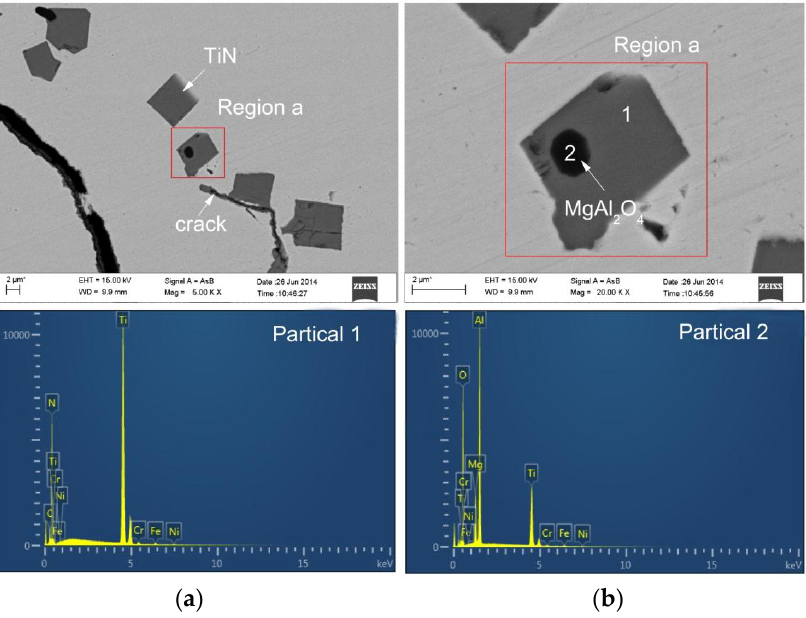
Figure 7. SEM images of an Incoloy800Hsuperalloy sample obtained in Set II. ( a ) TiN with and without nucleus; ( b ) TiN with nucleus.